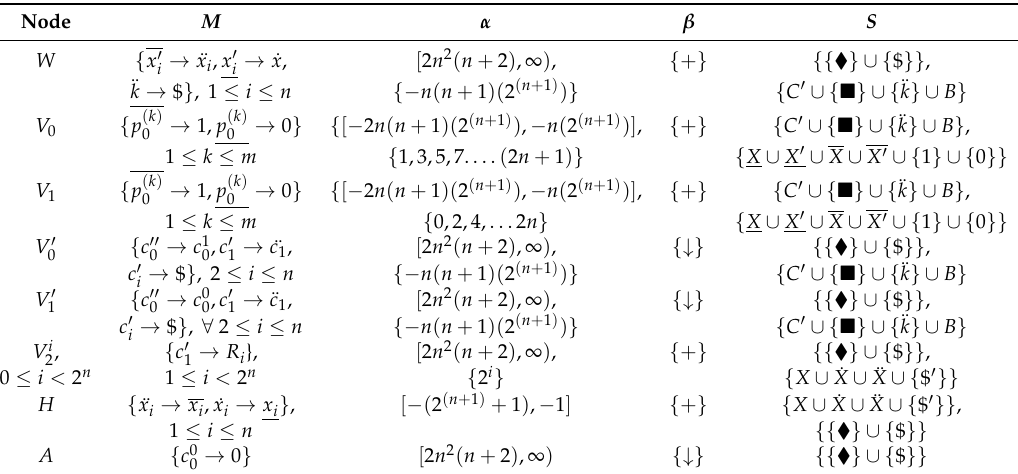
Table 5. Internals of the nodes of the subnetwork Val